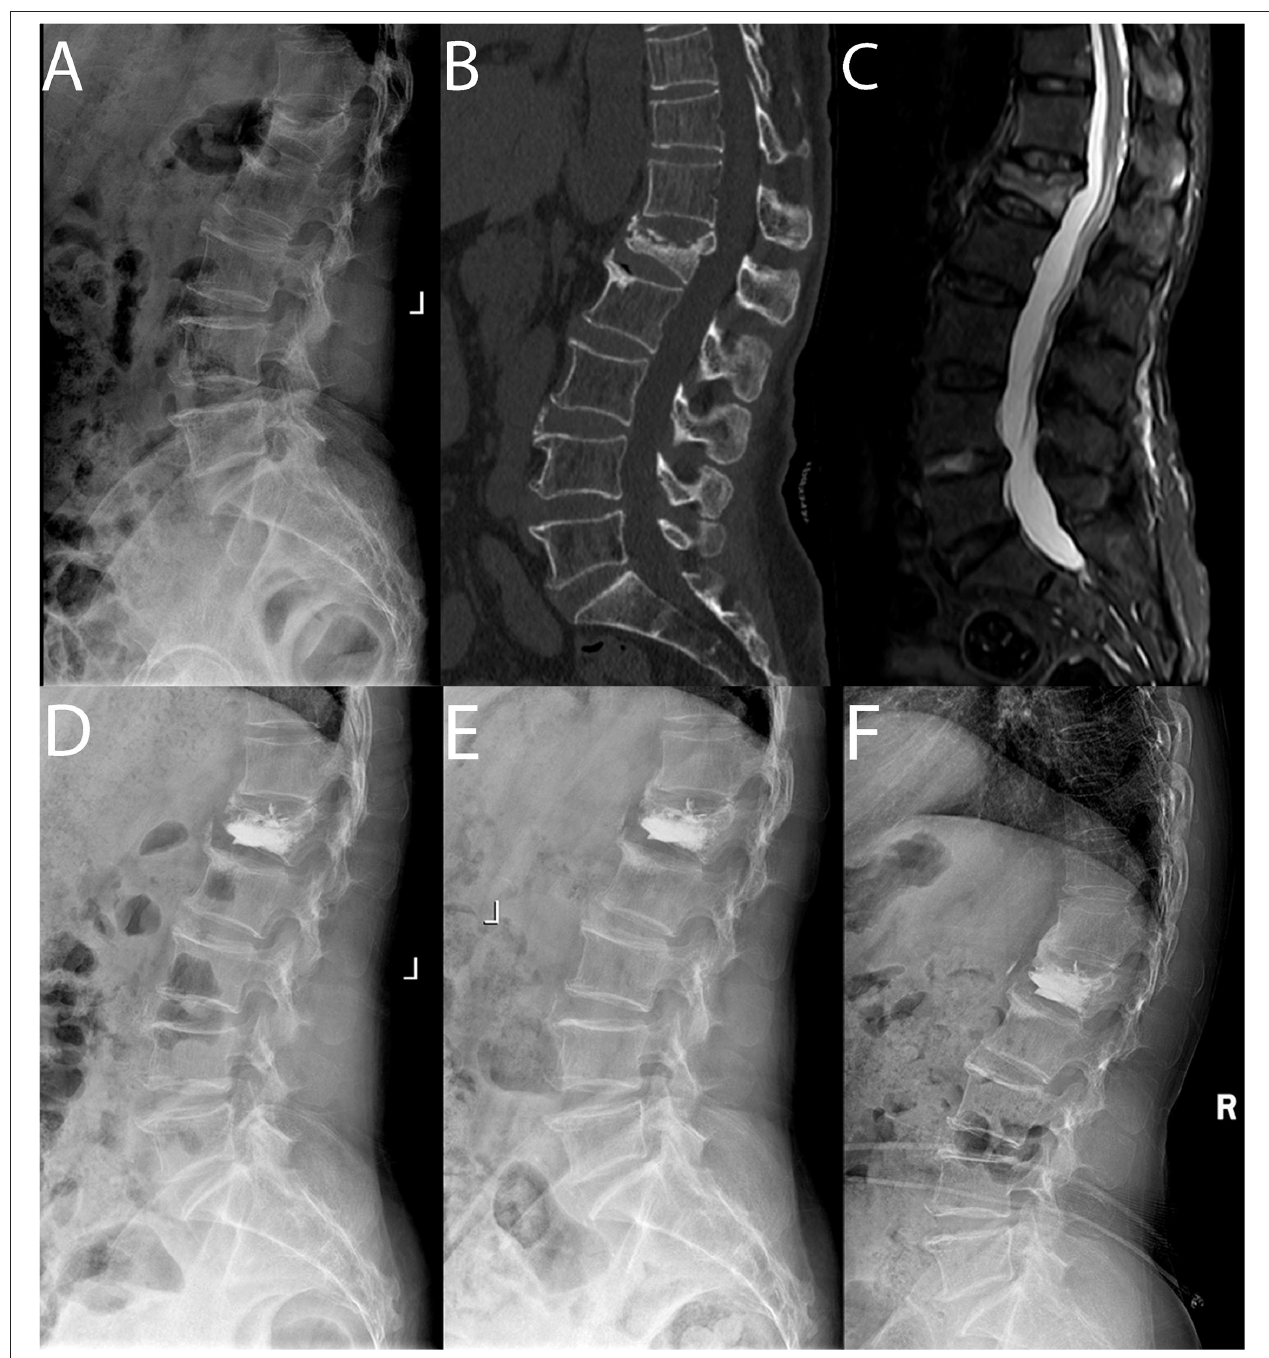
FIGURE 1 | Pre-operative sagittal lateral view (A) , sagittal computed tomographic scan (B) , sagittal fat-suppressed sequence in MRI (C) , post-operative sagittal lateral view (D) , sagittal lateral view 1 month after surgery (E) and sagittal lateral view at the final follow-up (F) of a 64-year-old female patient with L1 sOVCF was treated with